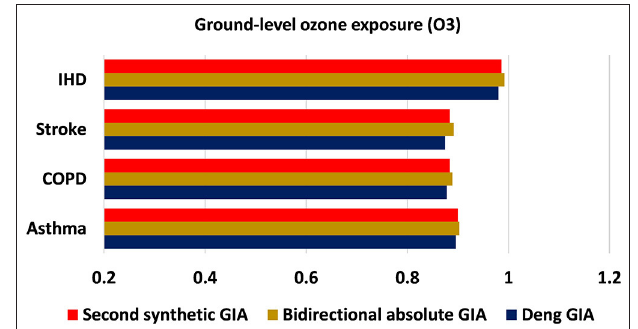
FIGURE 3 | Comparative assessment of ground-level ozone exposure based on GIA.